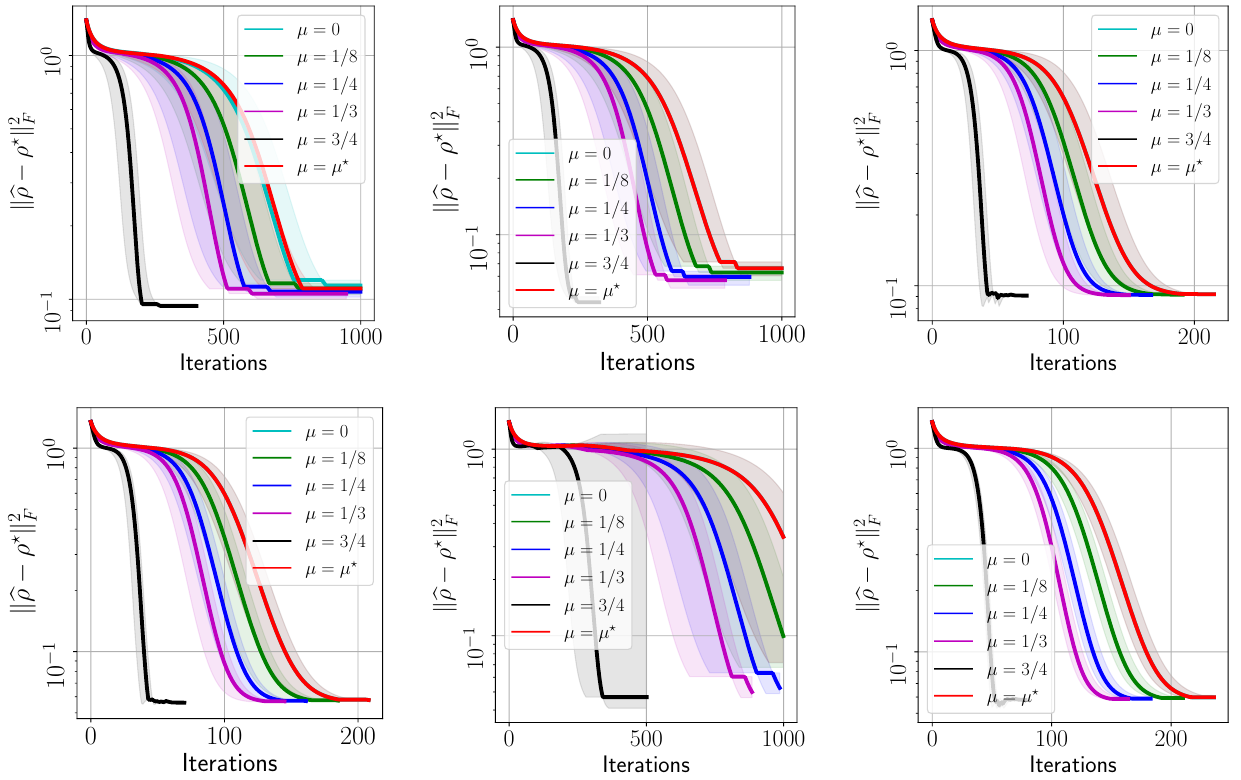
2 ρ ρ (cid:63) versus method iteration using synthetic IBM’s quantum F (cid:107) − (cid:107) ( 6 ) with 2048 shots; Top-middle : GHZ − (cid:98) ( 8 ) with 4096 shots; Bottom-middle : Hadamard ( 6 ) with −